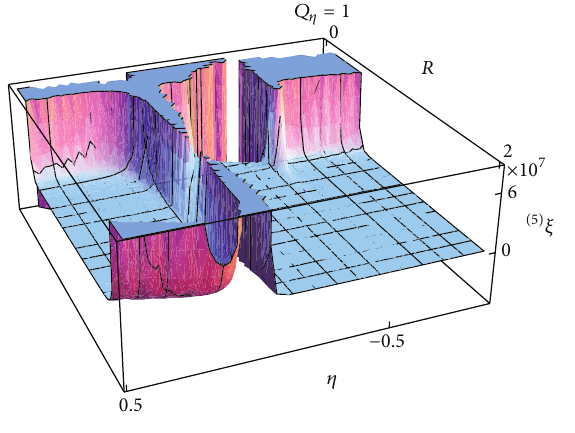
Figure 8: 5D Kretschmann invariant for 𝑄 𝜂 = 1 , for Λ = 0 .